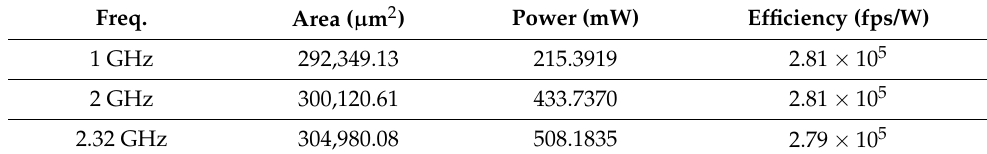
Table 4. ASIC implementation results.